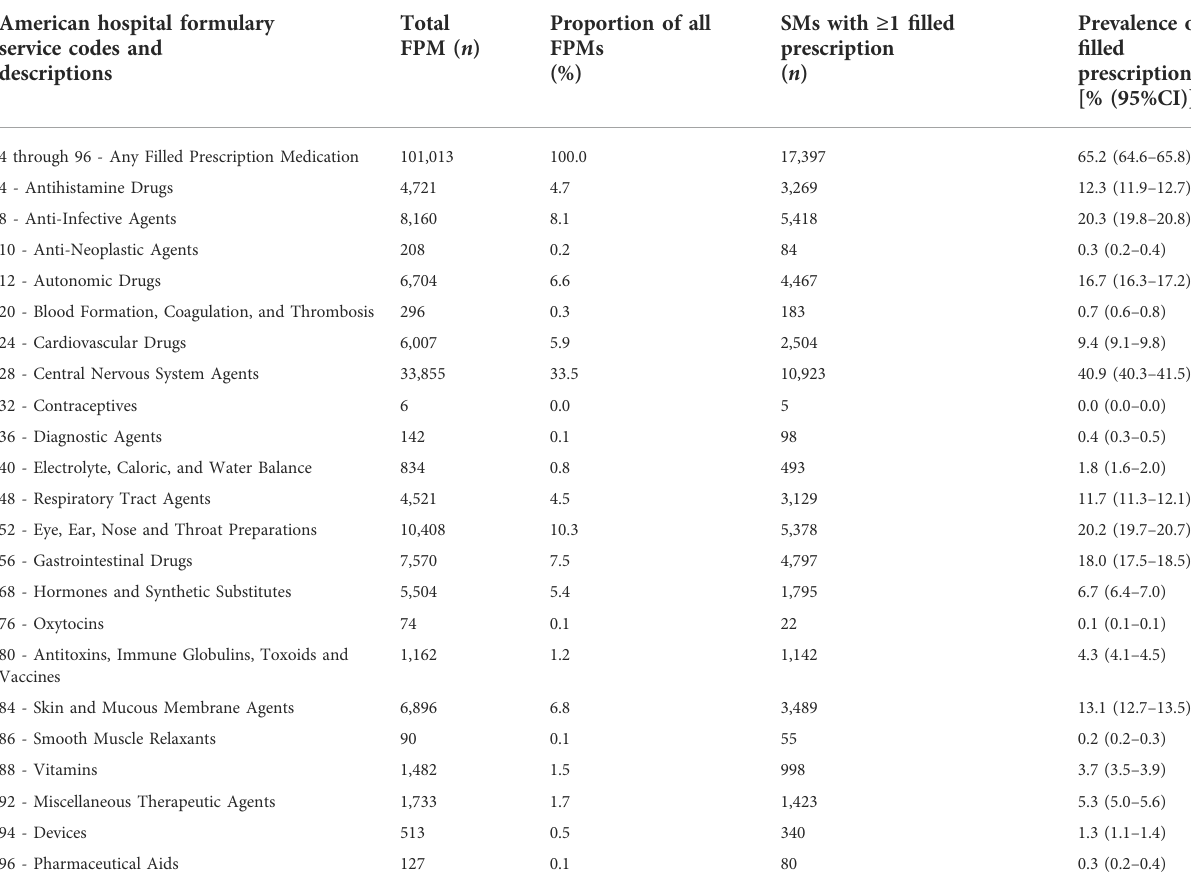
TABLE 1 Prescription medications fi lled by service members by fi rst tier American hospital formulary service pharmacologic-therapeutic drug classi fi